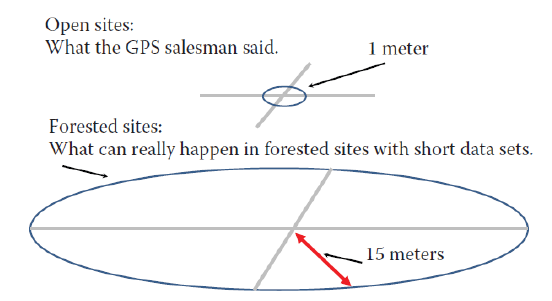
Figure 5. Manufacturer specified precision are usually for open sites and long datasets. Adapted from Ogaja Figure 2. Visibility obstruction diagram of MMA3289, view of the sky.